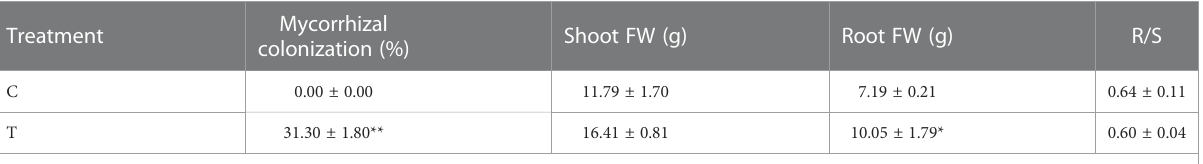
TABLE 1 Results of mycorrhizal colonization and plant biomass.